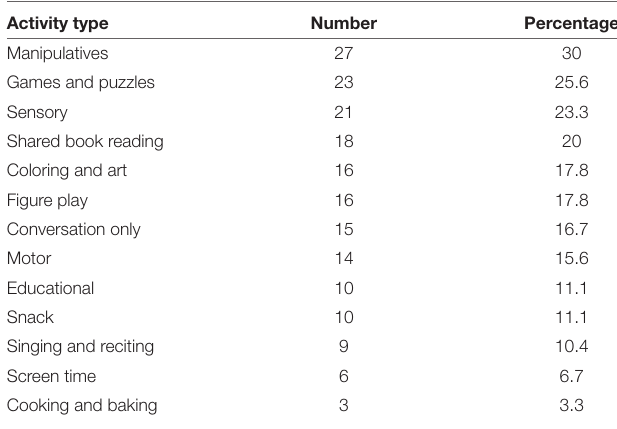
TABLE 4 | Percentage of parent-child dyads engaged in different activity